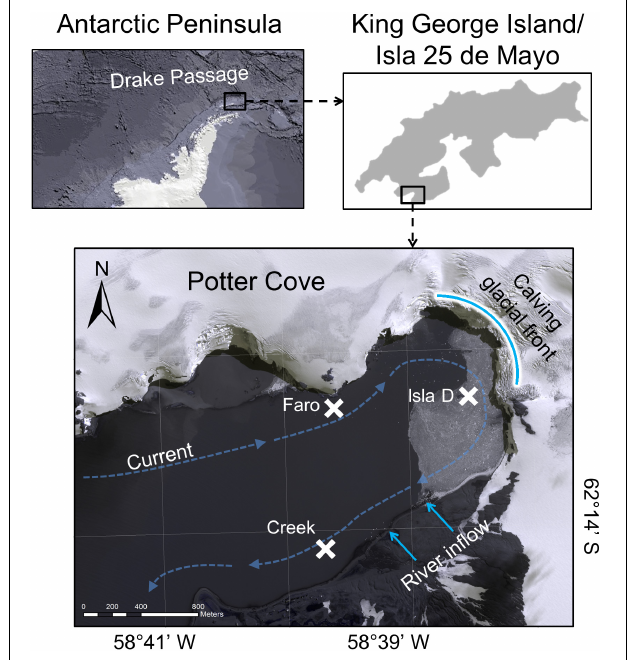
FIGURE 1 | Study site Potter Cove. At Faro, Creek, and Isla D, sediment cores for microphytobenthic analyses and primary production estimates were recovered by SCUBA divers. The position of sampled locations is marked with a cross. The curved, bright blue line marks the front of the Fourcade glacier. The bright blue arrows indicate river run-offs supplied mainly by glacier, permafrost, and snowmelt water. The dashed blue arrows indicate the direction of the main current in Potter Cove. More detailed information about the locations is given in Table 1 .